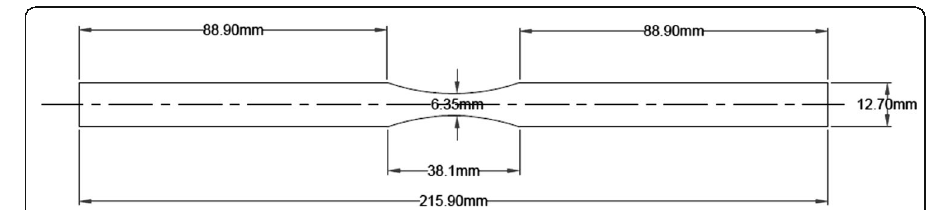
Fig. 1 Fatigue sample dimensions in